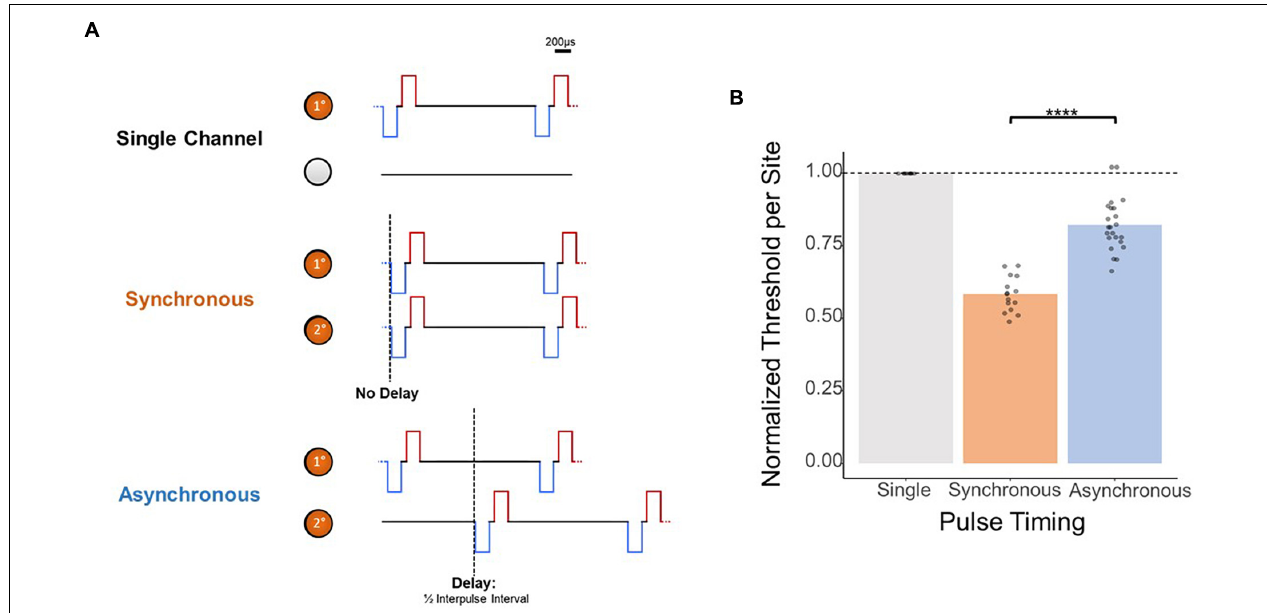
FIGURE 5 | Effect of synchronicity of 2-site simultaneous stimulation on threshold charges. (A) Layout of stimulated channels and stimulation paradigm for synchronous and asynchronous experiments. Primary electrode-site located 1,150 µ m from the cortical surface; secondary electrode-site located 100 µ m deeper than primary site. For synchronous pulses, no delay was present between the onset of stimulus trains for both channels. For asynchronous trials, a delay equal to 1/2 the inter-pulse interval (0.02 ms delay) was added to the secondary channel’s pulses. (B) Effect of 2-site simultaneous stimulation synchronicity on per-site threshold charge levels (threshold charges normalized to average single-site primary electrode-site thresholds; ****p ≤ 0.0001).